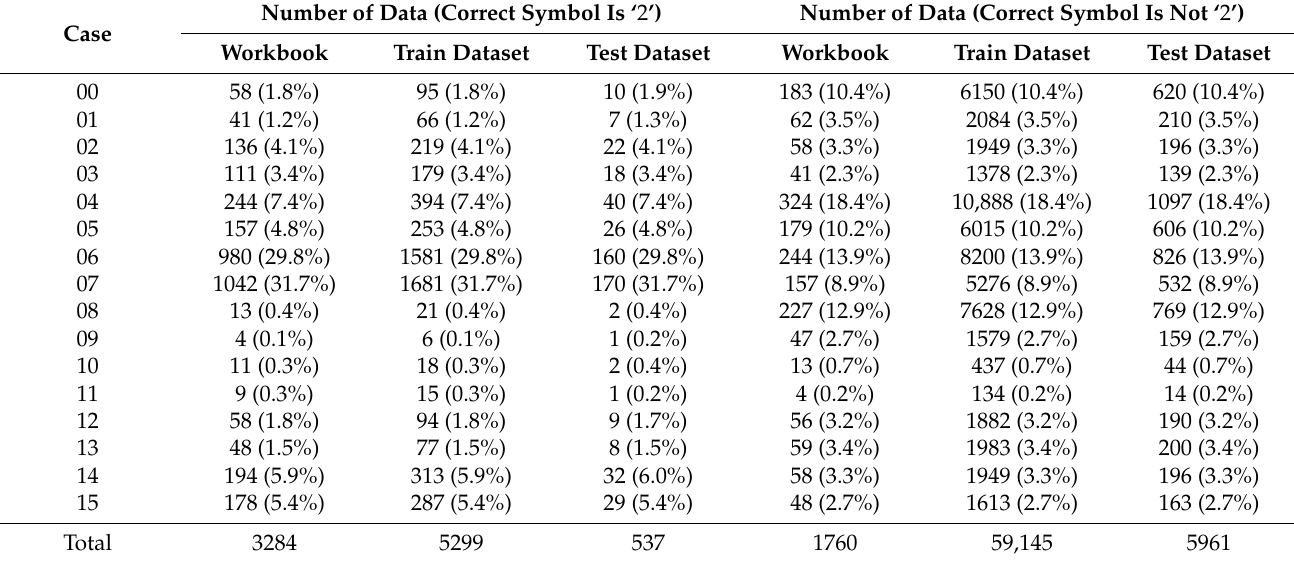
Table 6. Classification of LC data for symbol ‘2’ and the number of